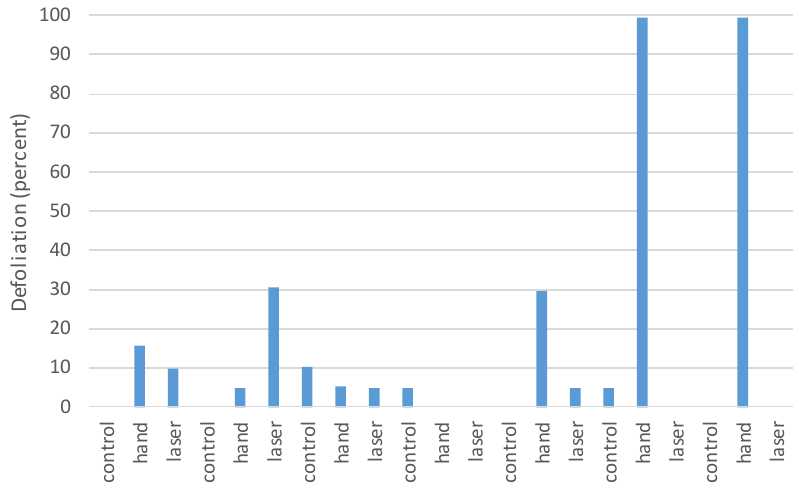
Figure 10. Defoliation efficacy for greenhouse ‐ grown plants utilizing large 11 L pots for replicated comparison of (control, hand ‐ girdled, laser ‐ girdled).